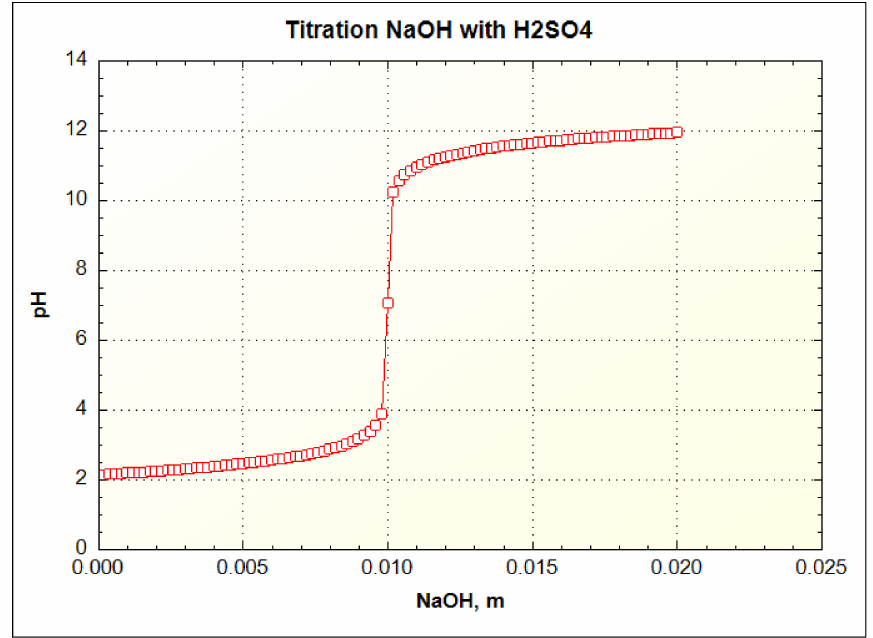
Figure 4. Simulation of pH titration of 5 millimolal H 2 SO 4 with 20 millimolal NaOH added in small increments using REACT command and USER GRAPH to plot results and to check accuracy of computation. The titration is plotted in terms of total number of moles used in the